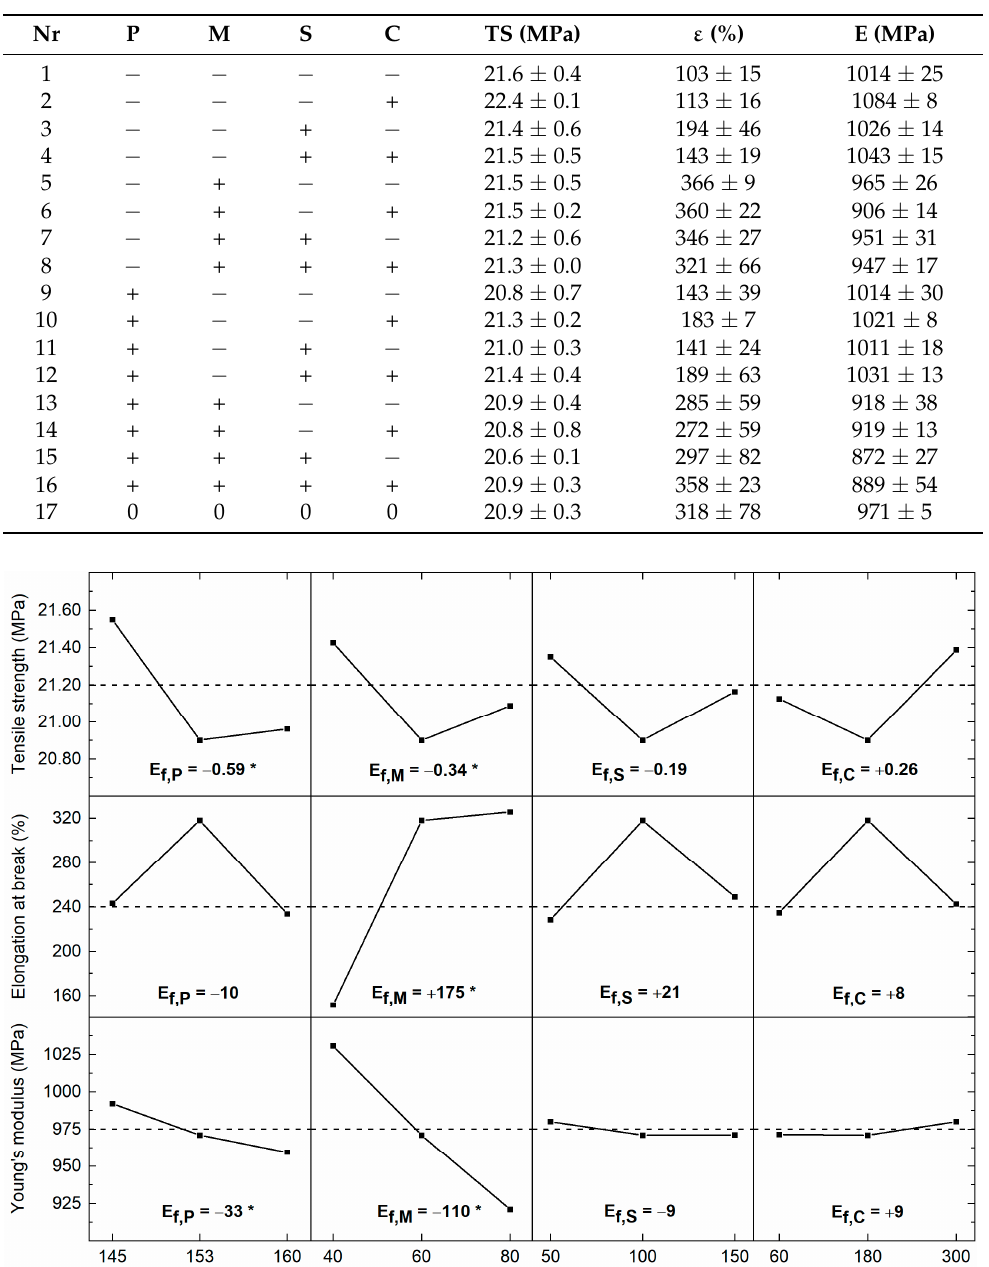
Table 4. FFD with factors, levels, and response data (mechanical properties) for tensile strength,